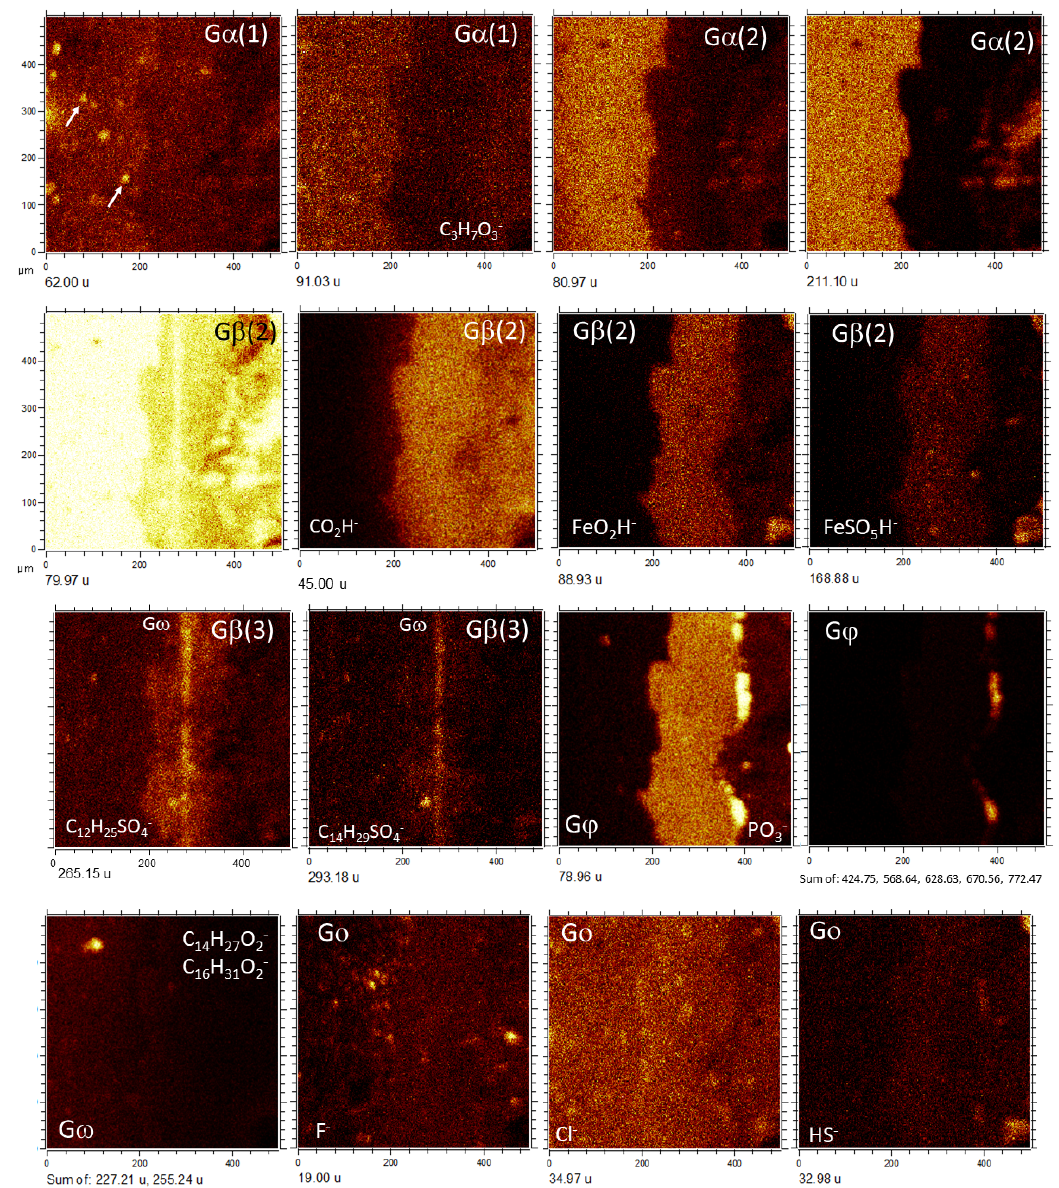
Figure 7. Identification of the morphological groups through the anion ToF-SIMS images in TA2. As for cations, it has been characterized G α , G β , G γ , and G φ , plus a new group G ο that includes the distribution of different anions with unrelated patterns. Minor pattern changes inside G α and G β have suggested to separate them into several subgroups as it has also observed for the TA2 cation groups. The HS - distribution classified into G ο follows the phosphatic discontinuous laminas and the NH 4+ -bearing nodules, which are associated with the presence of amino acids. The ToF-SIMS images were obtained from a rasterized surface area of a 500 μ m square.